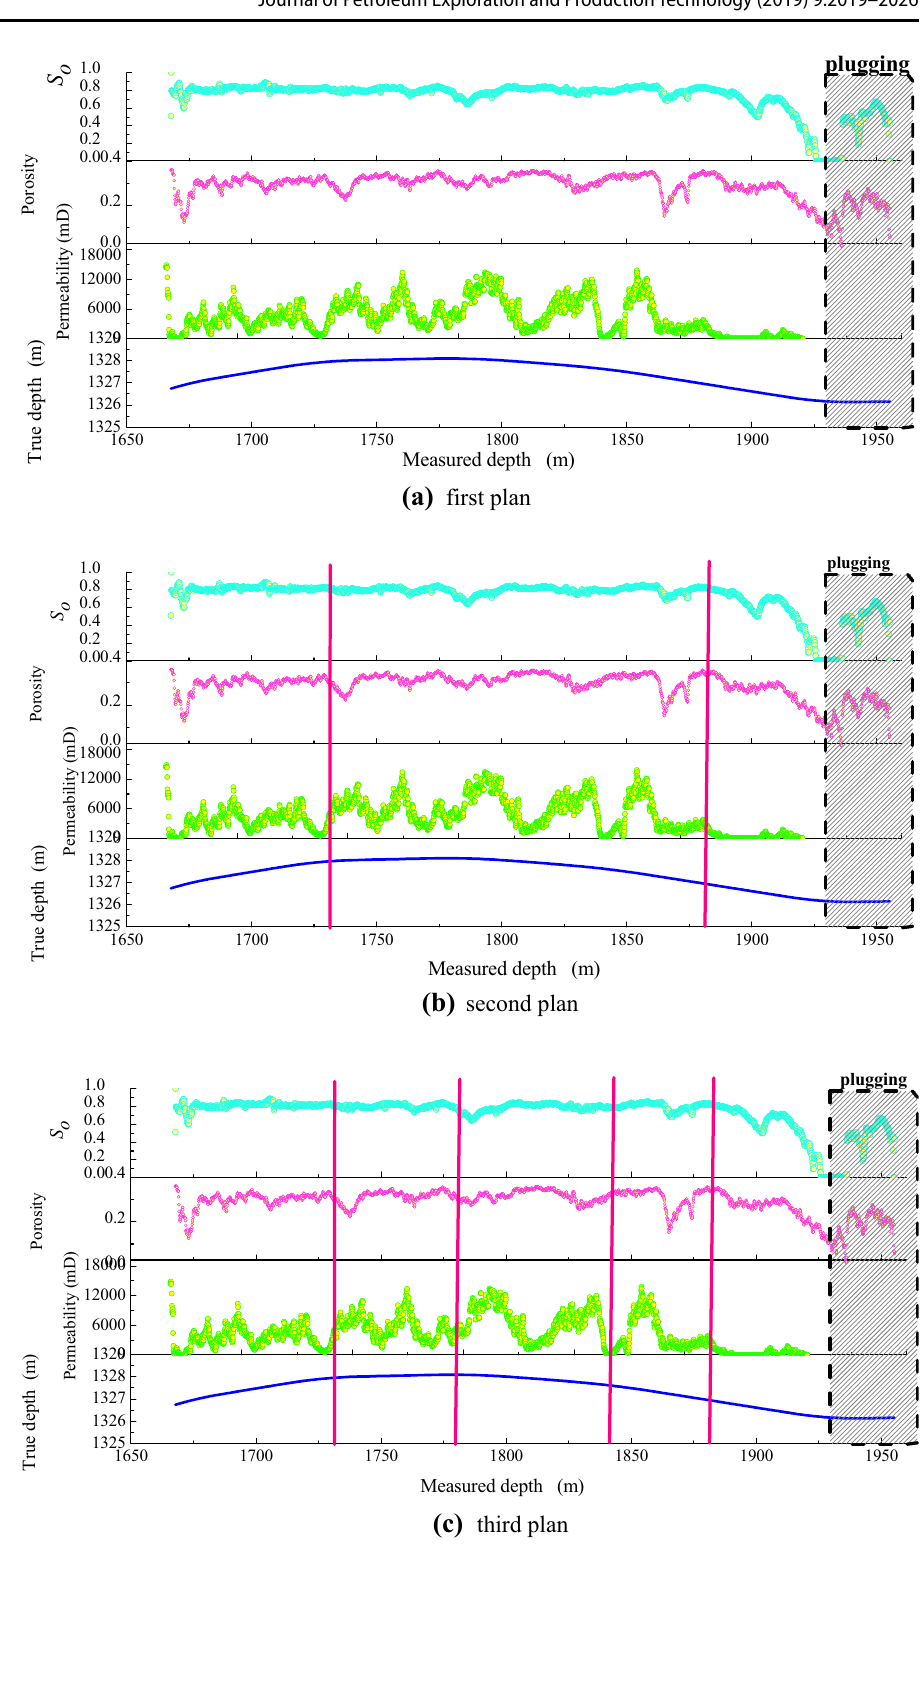
Fig. 8 The detailed segments of four